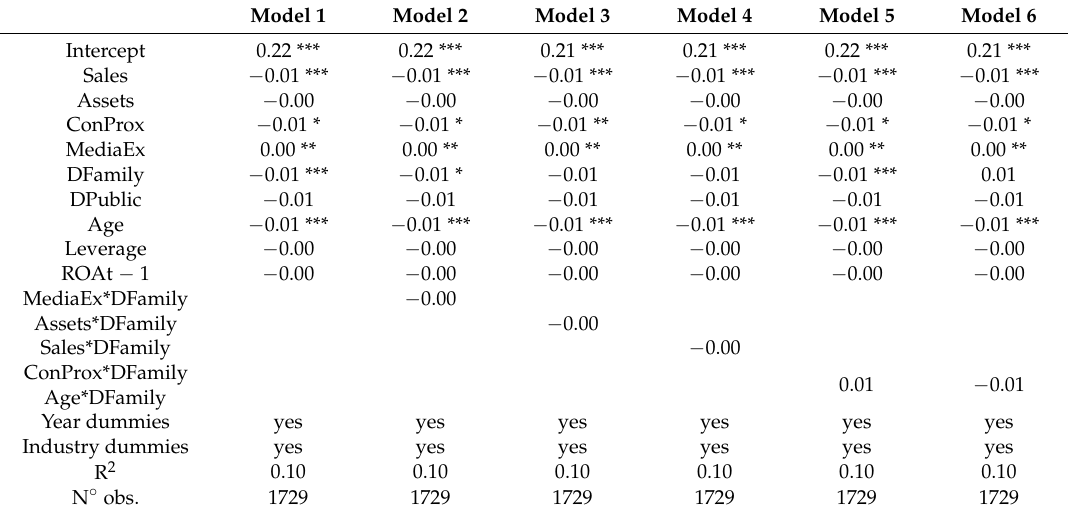
Table 3. OLS pooling regressions with time and industry fixed